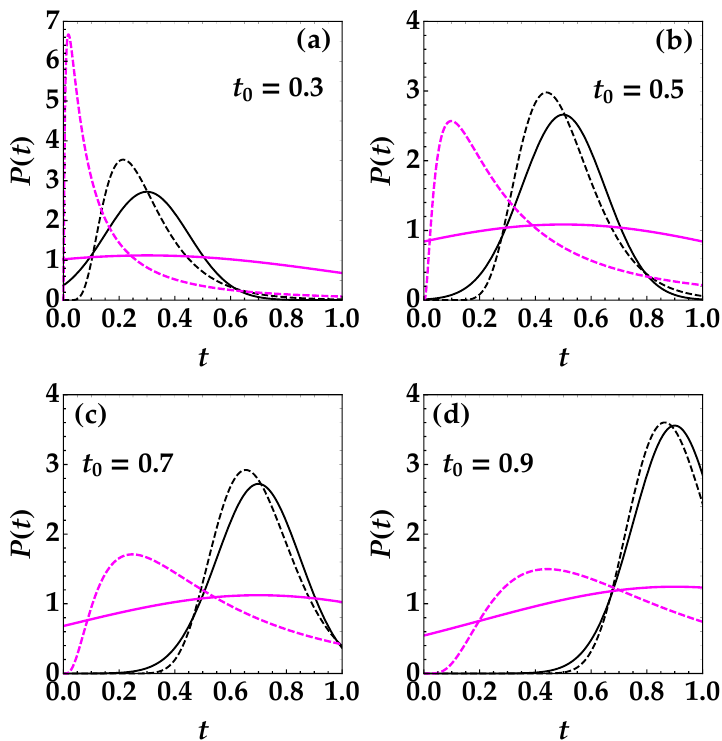
Figure 2. Gaussian (solid lines) and log-normal (dashed lines) probability distributions of t in the interval (0, 1). The four panels ( a – d ) correspond to different choices of the mean value t 0 of the distributions, as indicated in the label on top of each panel. Inside each panel, the different colors correspond to different choices of the standard deviation: σ 0 = 0.15 is represented in black, while σ 0 = 0.7 in